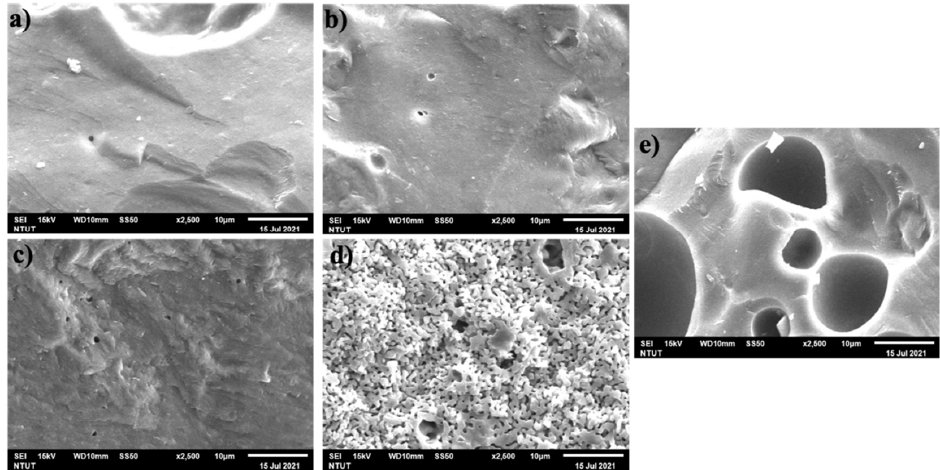
Figure 4. SEM images ( × 2500) of ( a ) R1, ( b ) R2, ( c ) R3, ( d ) R4, and ( e ) R5.